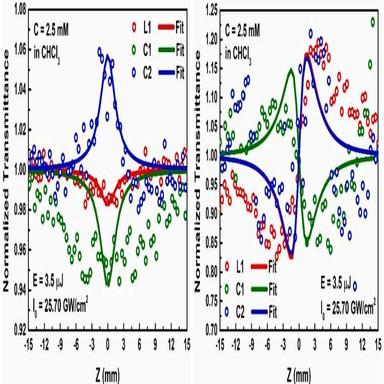
Typical OA and CA Z-Scan curves for the investigated samples with a concentration 2.5 mM dissolved in chloroform CHCl3.